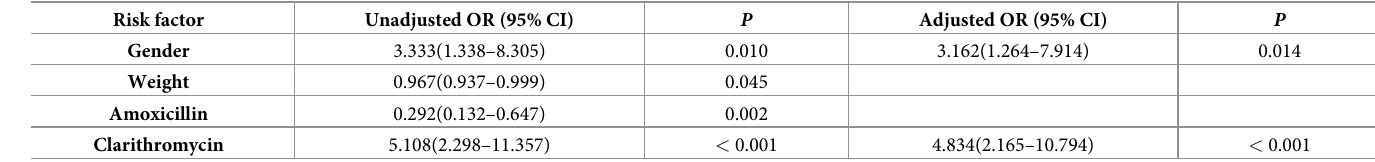
Table 5. Univariable and multivariable logistic regression analysis for independent risk factors for furazolidone-associated fever in patients. Risk